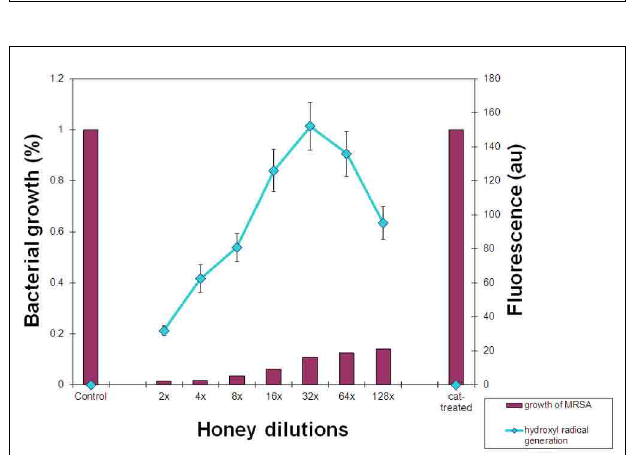
FIGURE 6 | Relationship between hydroxyl radical generation and inhibition of MRSA cultures by honeys H77 and H76 supplemented with Cu ions. Columns represent growth of MRSA expressed as a percentage of control (growth of MRSA in the absence of honey, 100%) exposed to the serially diluted honey. A line represents fluorescence of hydroxyl radicals trapped by APF during incubation of honeys with MRSA. Cat-treated sample represents growth of MRSA in the presence of honey pre-treated with catalase and then supplemented with Cu